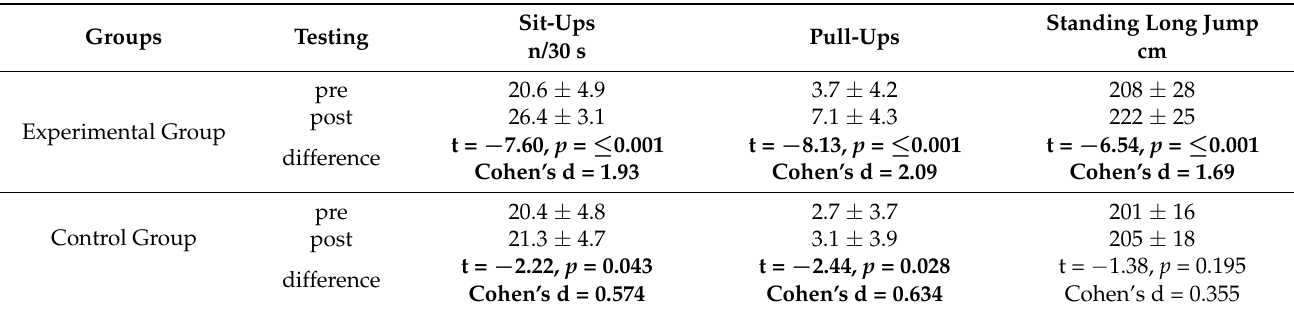
Table 8. Changes in the selected parameters of physical fitness in the experimental (Ex) and control (Co) groups following an 8-week period.